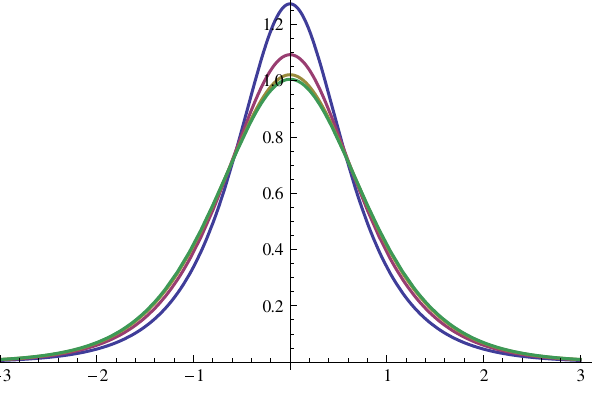
FIG. 3. Magnetic field of the 12Q12 quadrupole (dots), mea- sured at radius of 150 mm in the median plane vs z in mm. The 12Q12 aperture radius is 155.6 mm, thus, The continuous curve is the magnetic field at this same radius using Eq. (8), normalized to agree at z ¼ 0